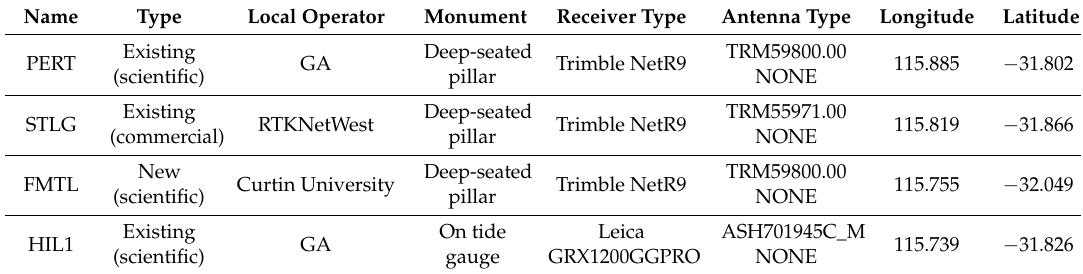
Table 1. Existing and new cGNSS infrastructure in the Perth region that was operating during the period of, and is also described in, this study (cf. Figure 1). GA—Geoscience Australia; RTKNetWest: